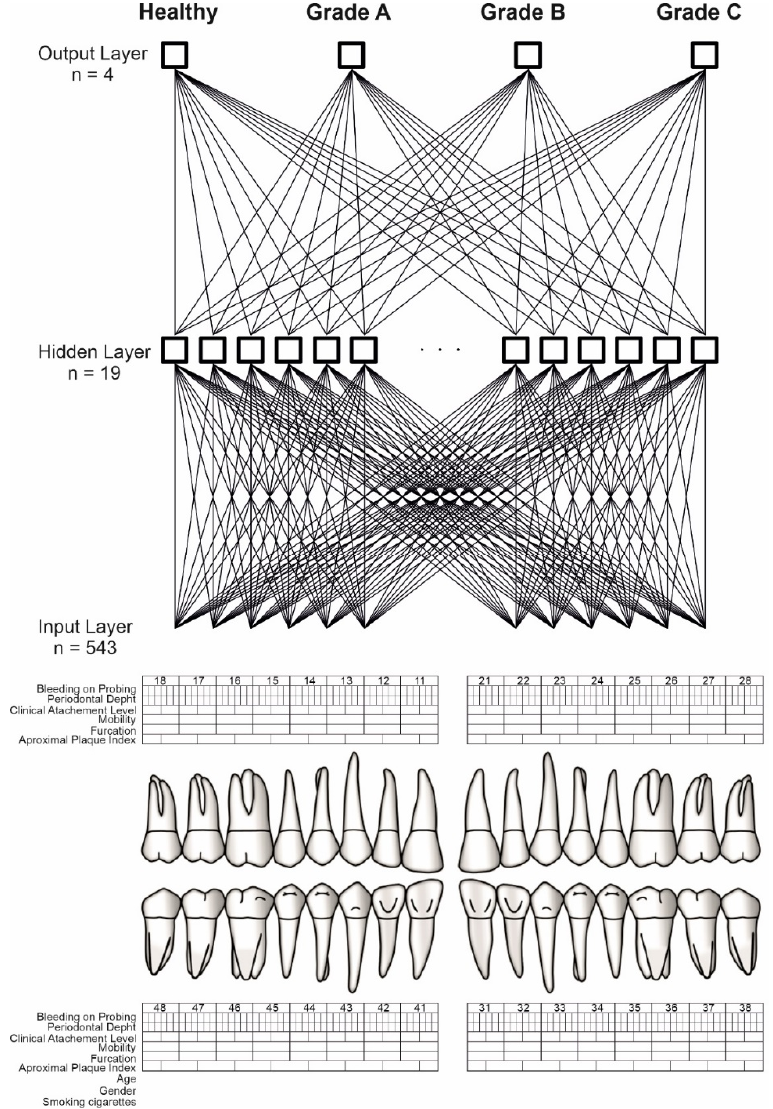
Figure 1. ANN construction. Source: https://www.periodontalchart-online.com/uk/ (accessed on